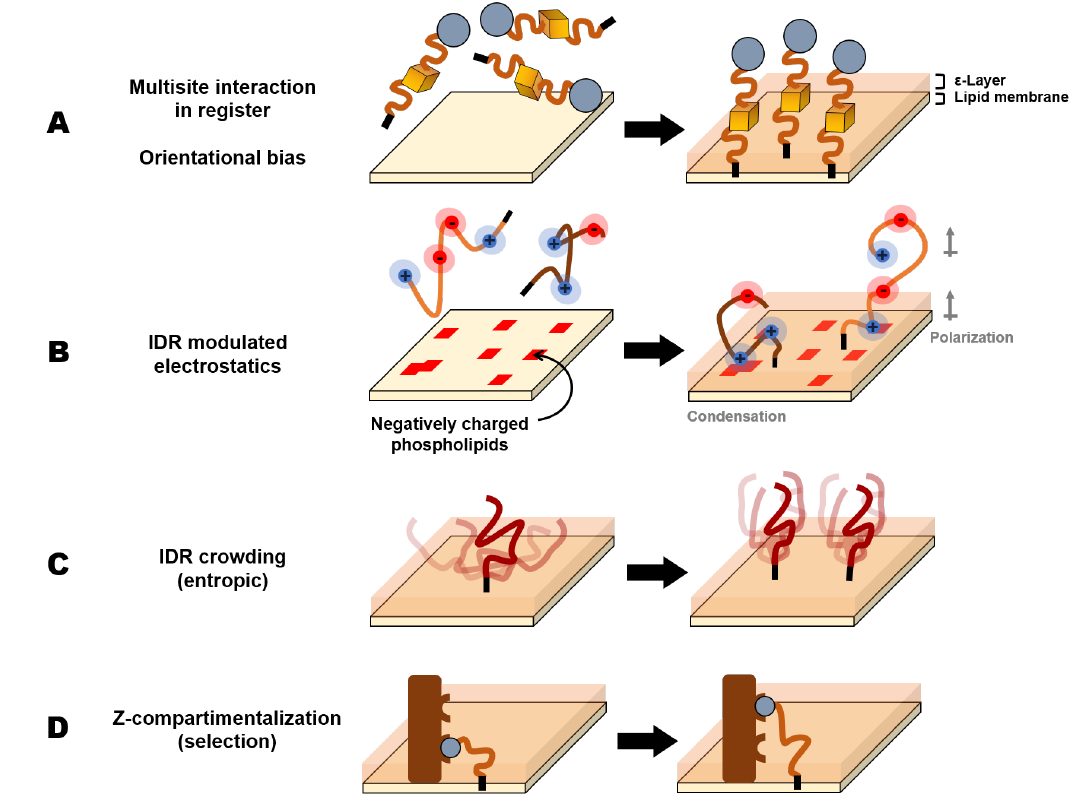
Figure 4: Emerging properties of the DBC. A. Enhancement of lateral interactions by placing interacting sites “on register” through membrane anchoring. B. Electrostatic interactions with the charged lipid membrane may affect the positional distribution of charged residues modulating the protein conformational space and the extension of the electrostatic effects propagated through dipolar interactions generated from oppositely charged residues in the IDP. C. IDP crowding has an entropic origin, resulting from the mutual restriction of the conformational space sampled by approaching membrane tethered IDPs. D. Z-compartmentalization refers to the selection of interacting partners/substrates depending on their location with respect to the membrane